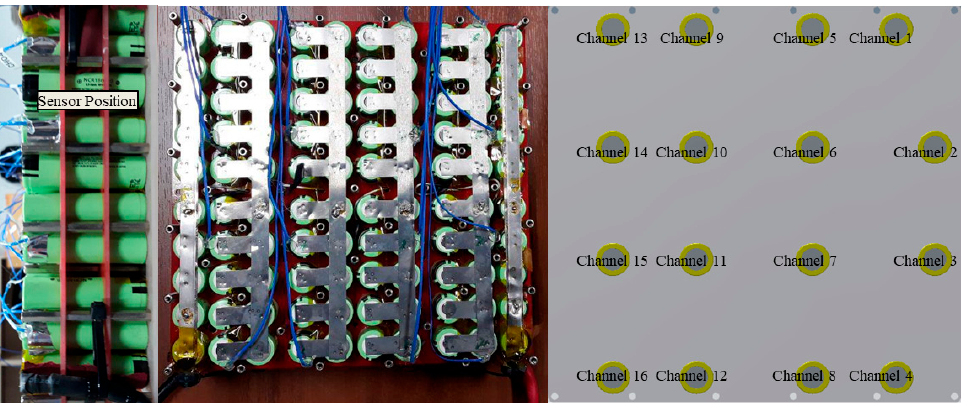
Figure 8. Thermocouple position selection and attachment .